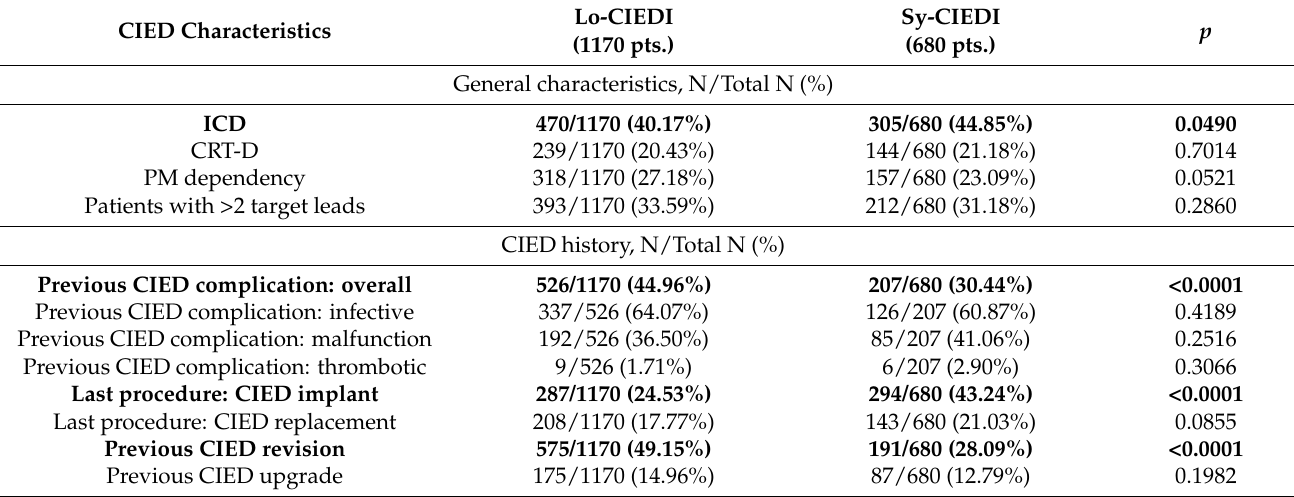
Table 2. CIED history and characteristics in patients with Lo-CIEDI vs.